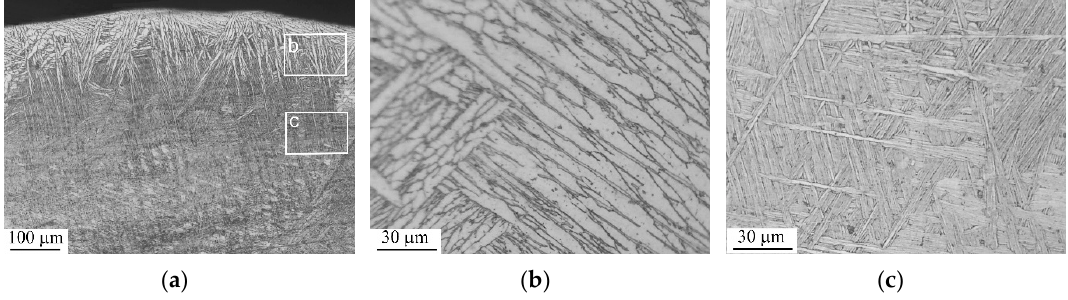
Figure 5. Microstructure within the outermost surface area ( a , b ) and the core region ( c ) of the EBF 3 -fabricated Ti–6Al–4V sample in the as-built state.